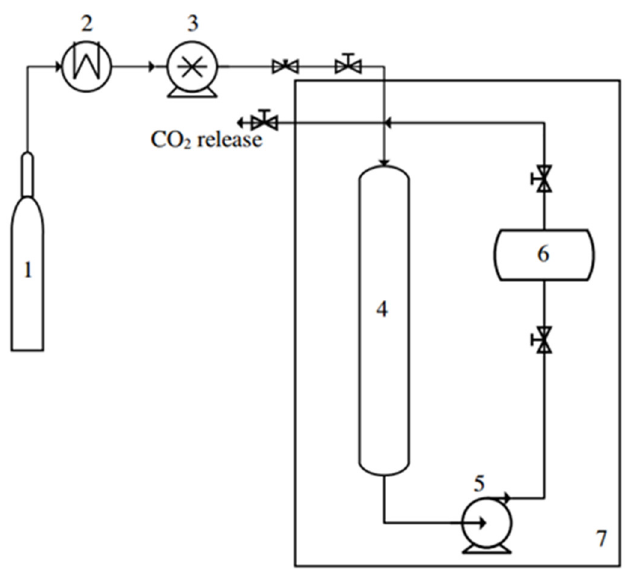
Figure 13. Supercritical CO 2 drying setup; (1) CO 2 tank, (2) cooler, (3) pump, (4) CO 2 buffer, (5) pump, (6) view cell chamber and (7) oven.